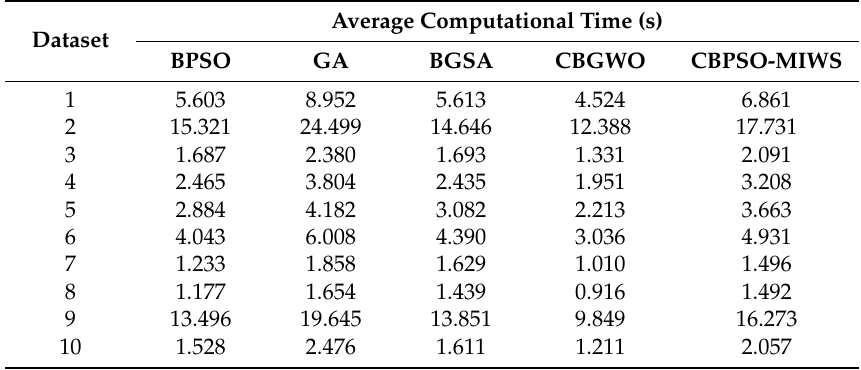
Table 5. The average computational cost of five feature selection